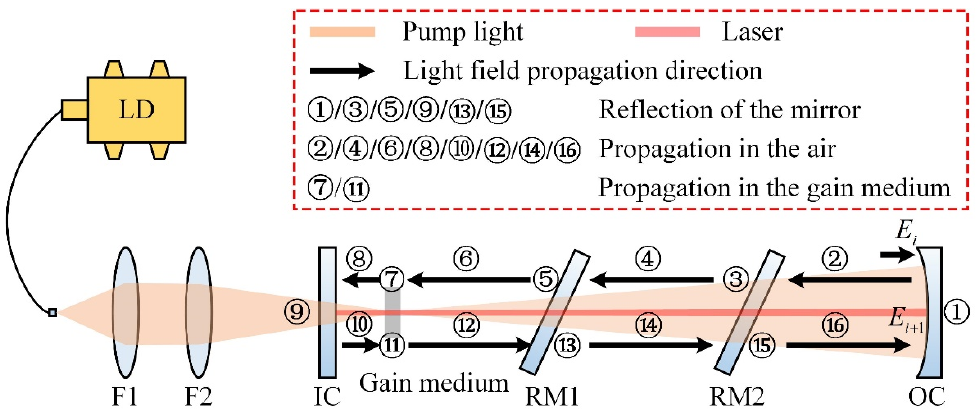
Figure 4. Schematic of the intra-cavity propagation iteration of the light field.